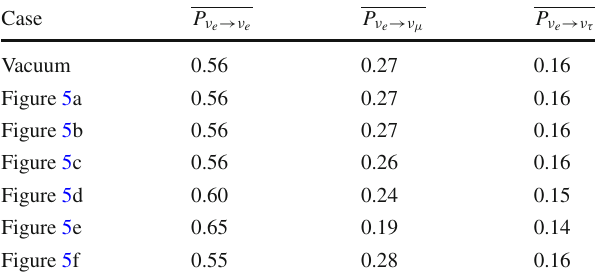
Table 1 Average values of the survival/transition probabilities for each neutrino flavor in vacuum ( λ = 0) and for the set of parameters corre- sponding to each case of Fig. 5. For cases 5a and 5b the values differ from those in vacuum only in the fifth decimal